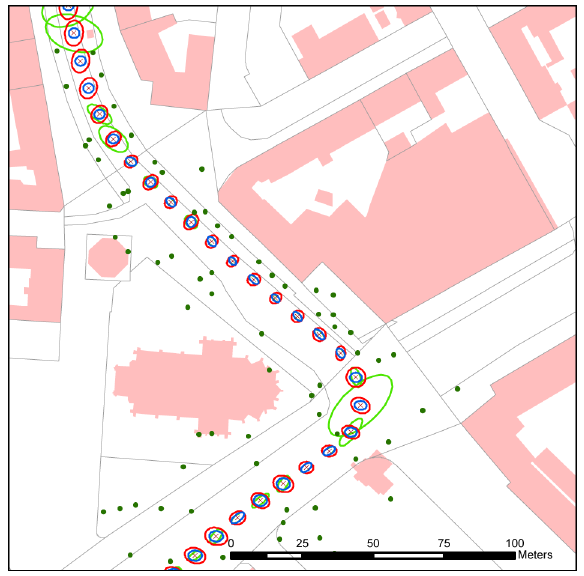
Figure 6. Positioning accuracy drawn as error ellipses for opening angle 100°, (green: without IMU, blue: precise IMU, red: automotive IMU). All ellipses scaled by a factor of 20. (Middle: green ellipses coincide with blue